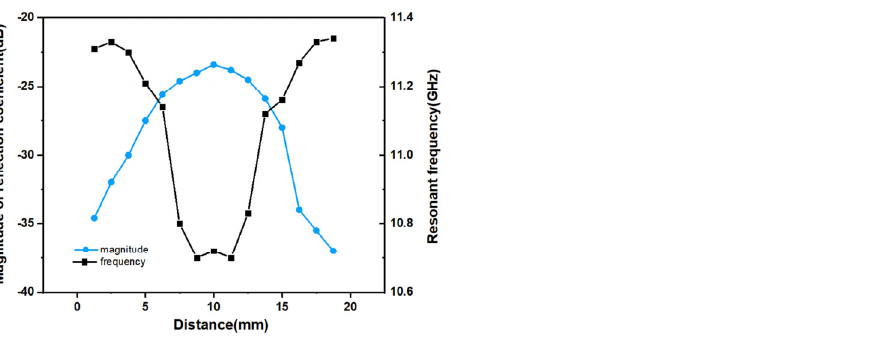
Figure 14. Pork skin with abnormal tissue mimicking phantom materials.